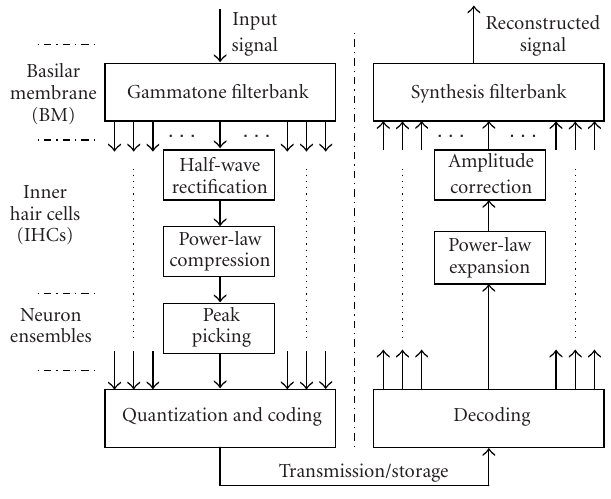
Figure 1: Invertible auditory